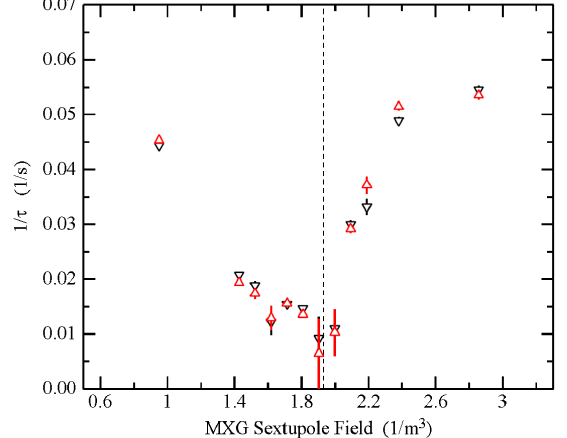
FIG. 17. Same as Fig. 15 but for wide beam scan 3, shown as a function of G ( S ¼ 1 . 95 m − 3 ).